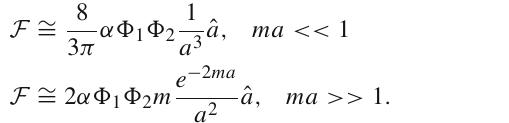
Fig. 5 Graphicfortheforce(58)dividedby 8 the induced vacuum charge around a point-like electric